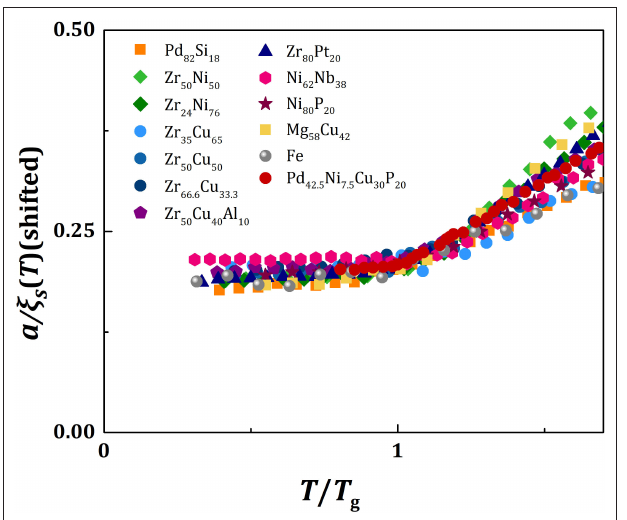
FIGURE 5 | The temperature dependence of viscosity of PdNiCuP liquid: Experimentally determined viscosity data of PdNiCuP liquid ( Kato et al., 2006; Mohr et al., 2019 ) compared to those calculated. The pentagonal symbol denotes the viscosity calculated with the ξ s ( T ) determined from the PDF measured by x-ray diffraction ( Ryu et al., 2019) using Equation (20), whereas the dashed line was calculated using the Curie-Weiss law, Equation (11).